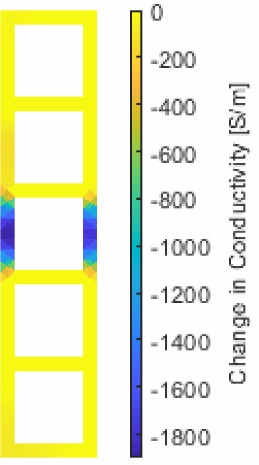
Figure 10. The change in conductivity distribution of the sensing mesh with respect to the baseline before tensile strain excitation. EIT results show the corresponding damage area when the vertical displacement of the load frame grips was loaded to 0.4